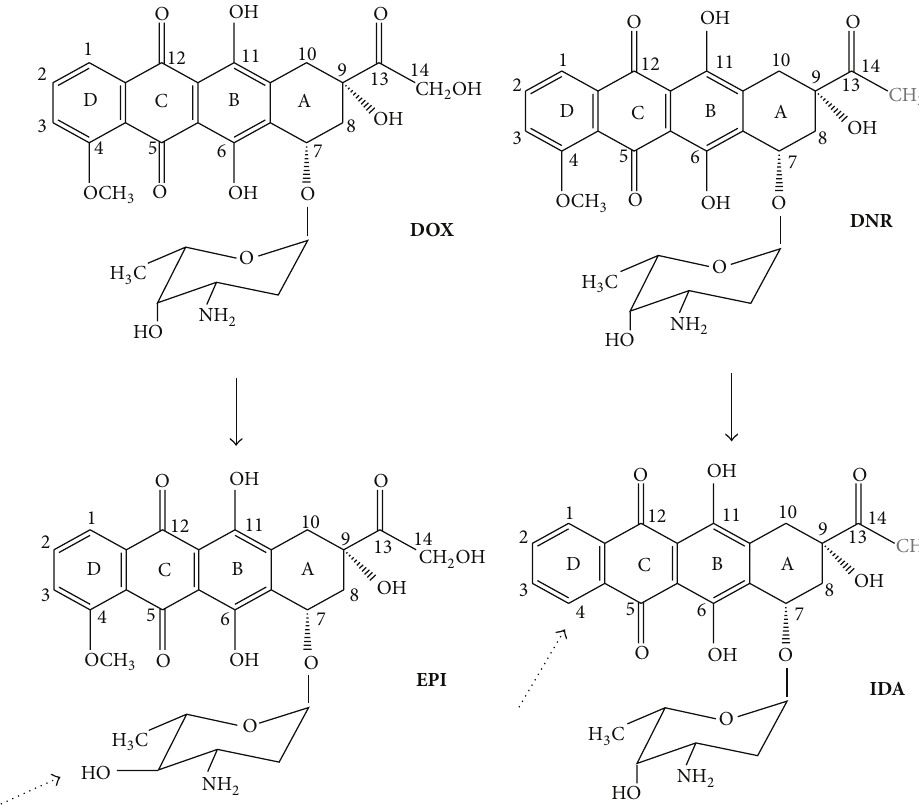
Figure1:ChemicalstructuresofmainAnthracyclines:doxorubicin(adriamycin):DOX,daunorubicin:DNR,epirubicin:EPI,andidarubicin: IDA. The differences between drugs are marked by